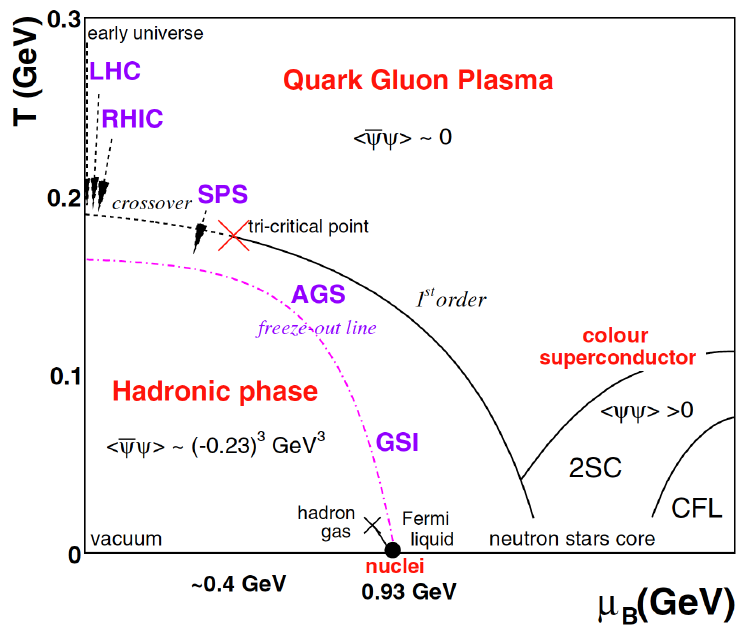
Figure 2. An illustration of typical phases of QCD matter that are expected to emerge at various values of the temperature T and the baryonic chemical potential µ B associated with U ( 1 ) B breaking (see Ref. [20] and references therein). Accelerators operating at different center-of-mass (c.m.) energies are depicted